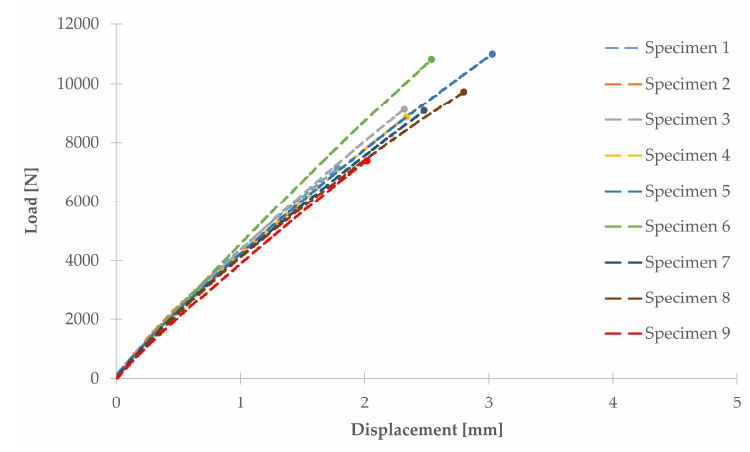
Figure 6. Load versus displacement curves.